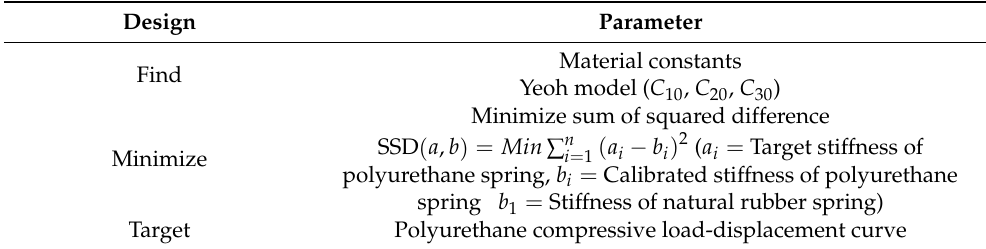
Table 1. Formulation of data-matching optimum